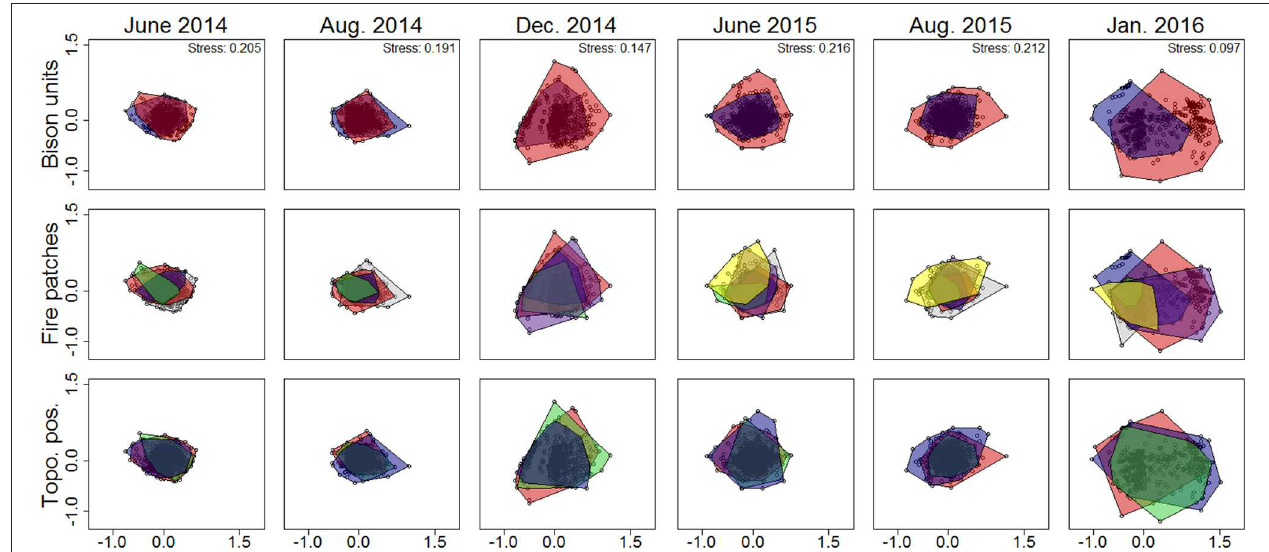
FIGURE 2 | Nonmetric multidimensional scaling (NMDS) ordination of vegetation structural metrics collected over six sampling periods (2014–2016) in a Nebraska Sandhills grassland managed with patch burning and bison grazing. Ordinations were duplicated for each sampling period with color envelopes corresponding to functional patch types. Bison unit color envelopes are red for the west and blue for the east. Fire patch color envelopes are red for 2012WF, blue for 2012RX, green for 2013RX, purple for 2014RX, yellow for 2015RX, and gray for the area unburned between 2012 and the end of the study. Topographic position color envelopes are red for north dunes, blue for south dunes, and green for interdunes. Stress values are included to show how well the ordination summarizes the observed distances among samples (stress > 0.3 is a poor representation, 0.2–0.29 is acceptable, 0.1–0.19 is great, and < 0.1 is excellent). The distance between points corresponds to the difference between samples with overlapping samples indicating no difference between